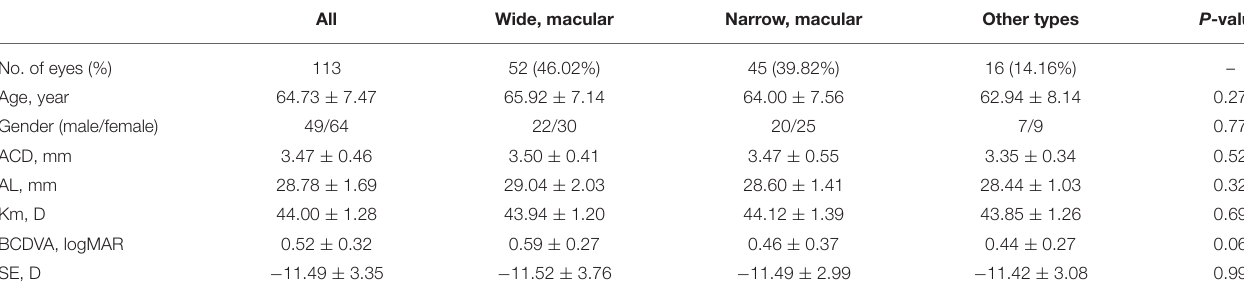
TABLE 1 | Preoperative baseline characteristics of patients with highly myopic cataract eyes and posterior staphyloma.